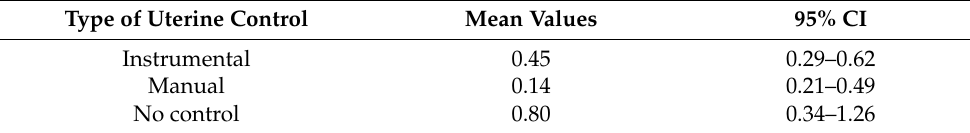
Table 17. The PUUS values of patients regarding the type of uterine cavity control.